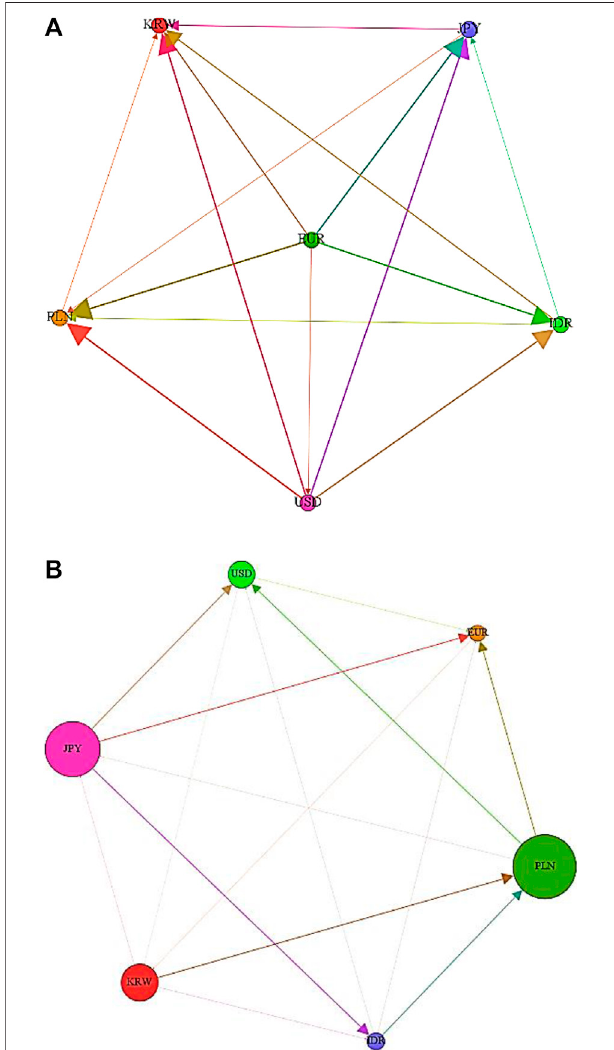
FIGURE 1 | Net pairwise spillover in different Bitcoin markets. Note: I. The lines between two nodes represent the net pairwise spillovers between two Bitcoin markets, while the arrows represent the spillover direction. II. (A) stands for net pairwise spillover for systematic volatility, while (B) stands for idiosyncratic